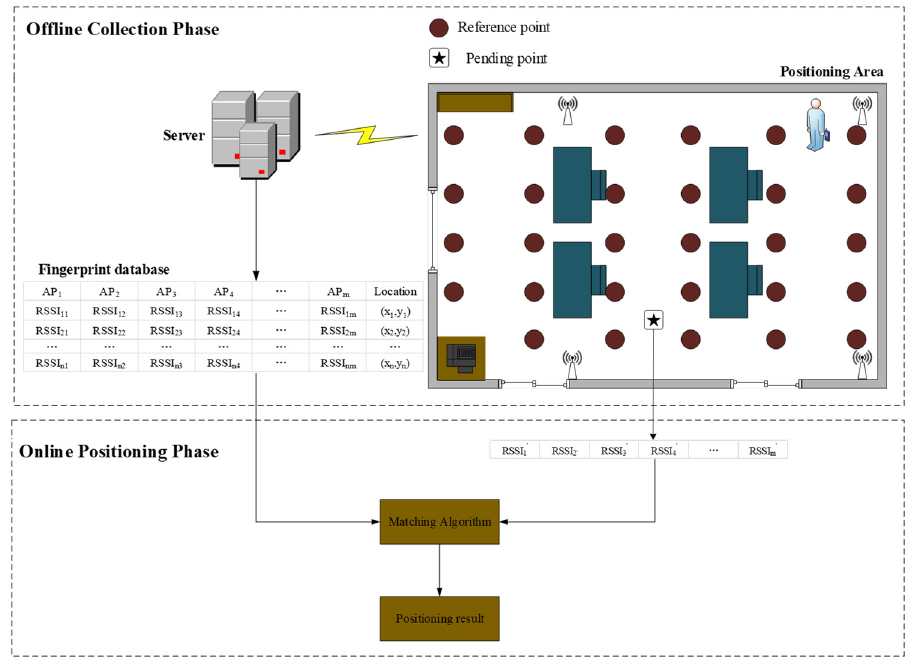
Figure 1. WiFi fingerprint positioning system.